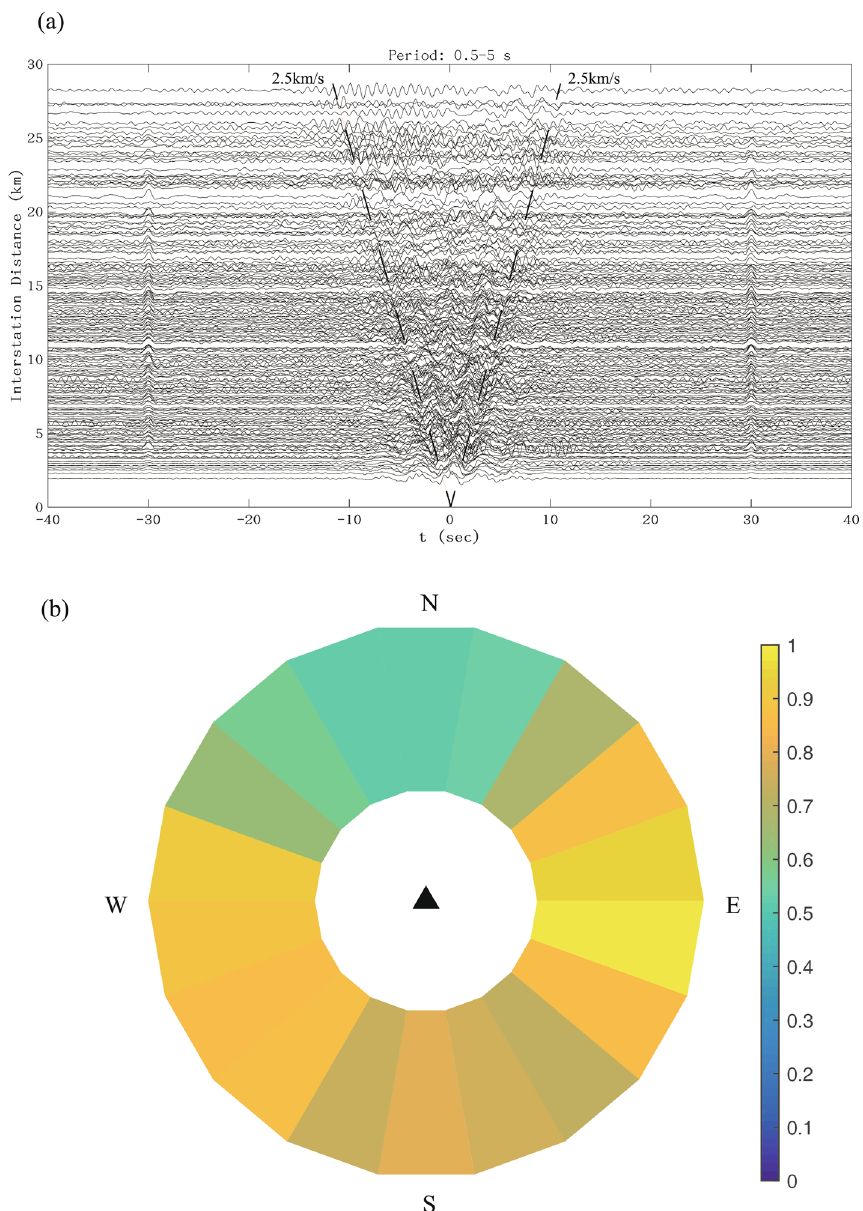
Figure 3. ( a ) Cross-correlation functions (CFs) with signal-to-noise ratio (SNR) greater than five in the 0.5–5 s period band obtained from normalized linear stacking method. ( b ) Azimuthal dependence of the normalized amplitudes of CFs for all station pairs in the 0.5–5 s period